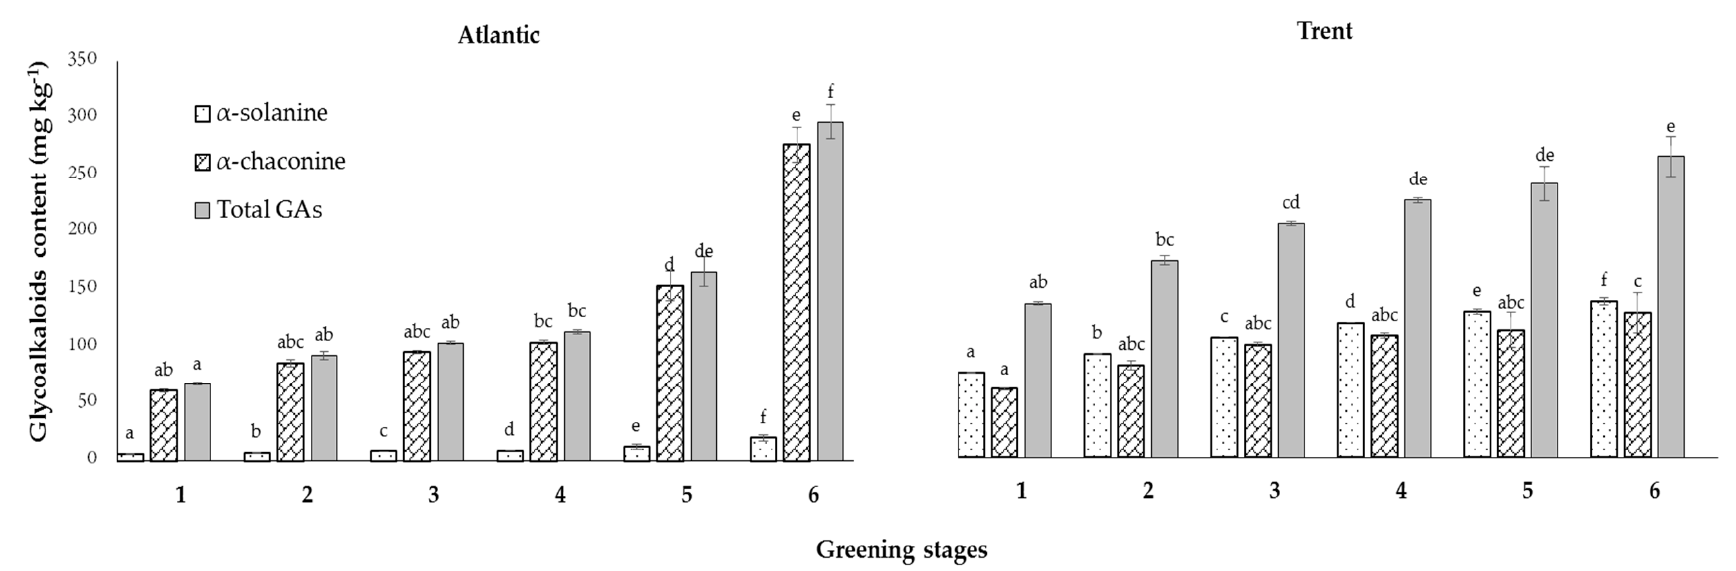
Figure 1. Glycoalkaloids content of ‘Atlantic’ and ‘Trent’ potato cultivars under six greening stages during storage at room conditions (22 °C) with a 12 ‐ h shift of light ‐ dark cycles. The bars with different letters indicate a significant difference ( p < 0.05) between the greening stages. The vertical bars represent the standard error of the mean (n = 10).